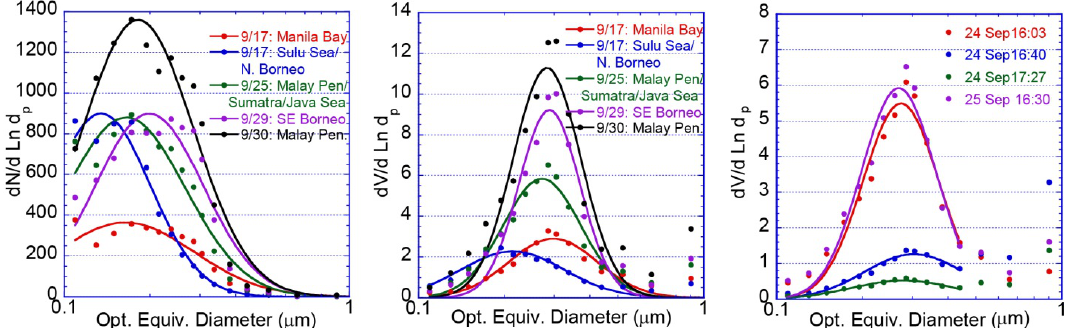
Figure 13. PCASP size distributions for selected regimes. (a, b) Number and volume distributions for early, middle and late cruise periods. (c) Volume distributions corresponding to the 24 September cold pool